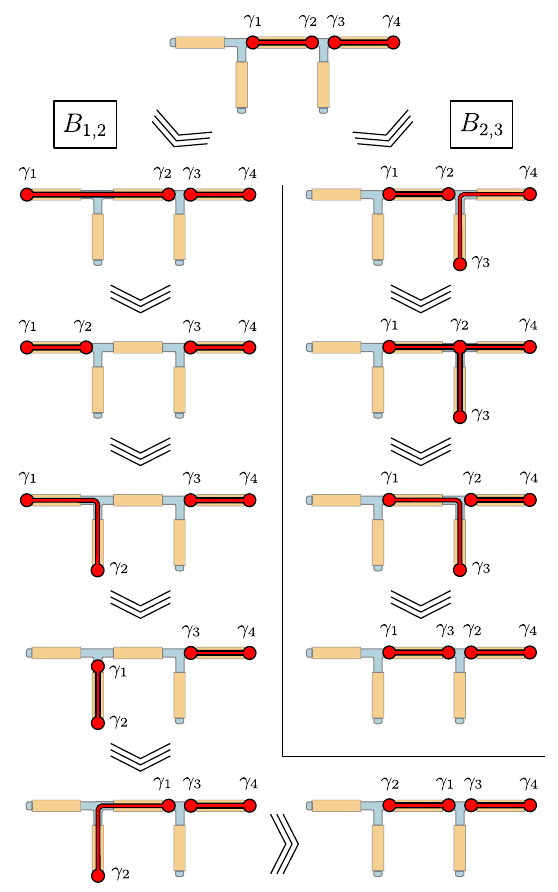
FIG. 2. Protocols for braiding operations in a double T junction, where red dots denote Majoranas and red lines connect the coupled superconducting islands (orange). Left diagrams: Braid- ing of γ 1 and γ 2 is achieved via a three-point turn in the left T junction. Right diagrams: To braid γ 2 and γ 3 , first γ 3 is moved from the right island to the bottom right island. Then, γ 2 is moved to the right island by first connecting all three islands in the right T junction and then disconnecting the right island. Finally, γ 3 is moved to the center island.